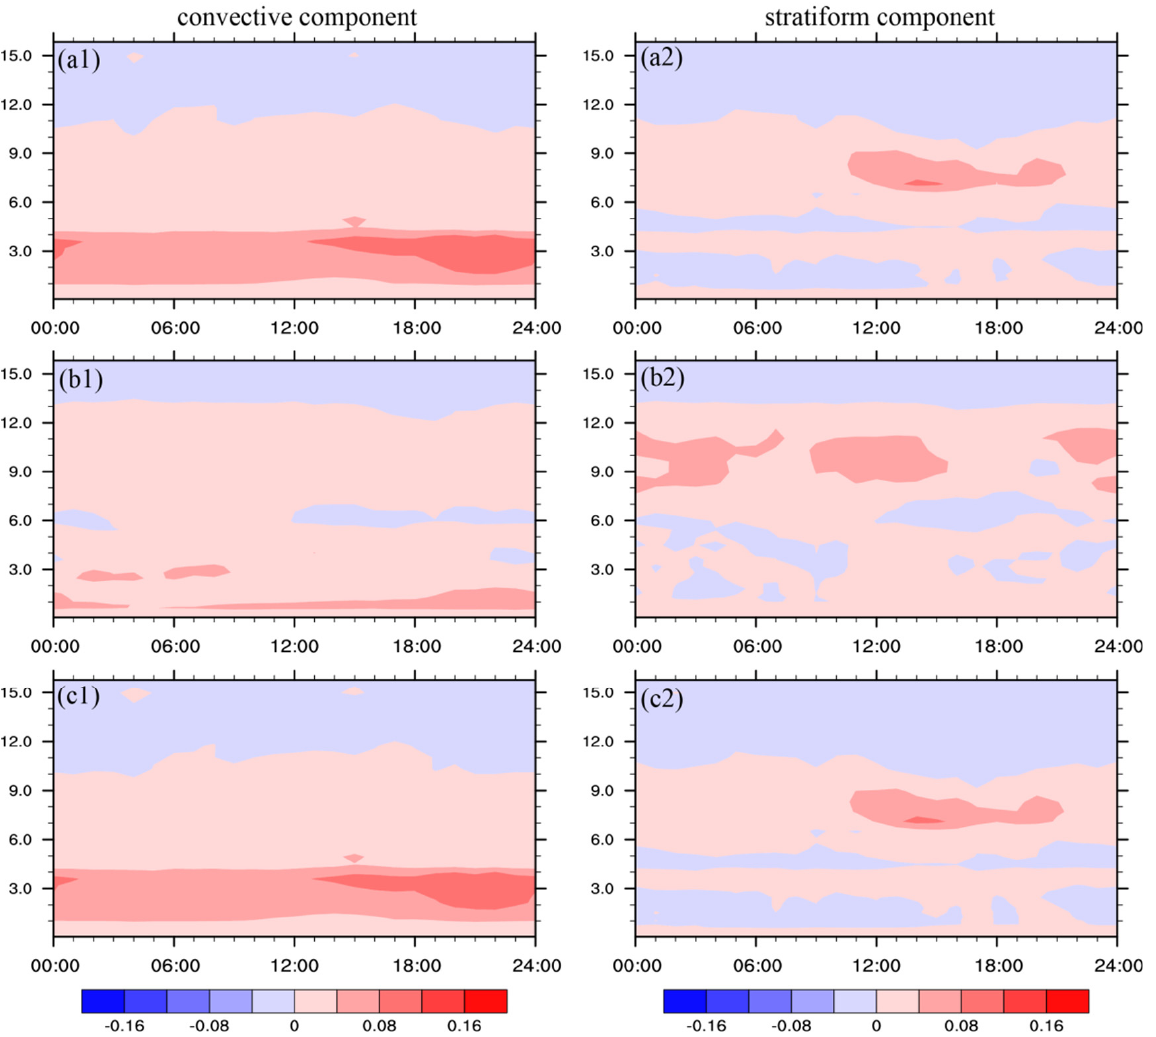
Figure 10. Diurnal composite of ( a1 , a2 ) the tendency of the perturbation kinetic energy ( ∂ K (cid:48) ), ∂ t ( b1 , b2 ) barotropic term ( G u ( K , K (cid:48) ) ), and ( c1, c2 ) G T ( K (cid:48) ) + G qv ( K (cid:48) ) + G ql ( P (cid:48) ) in the 2D model runs in ( a1 , b1 , c1 ) convective regions and ( a2 , b2 , c2 ) stratiform regions. The units are 10 − 1 J m − 2 s − 1 for the barotropic conversion term and J m − 2 s − 1 for the other terms.